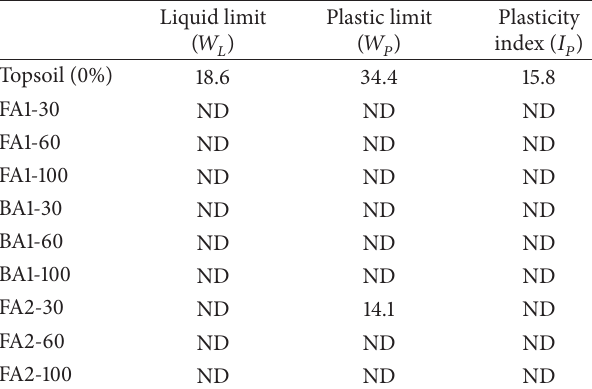
Figure 6: Soil composition of the simulated topsoil mixed with the coal ash at the mixing ratio of 0%, 30%, 60%, and 100%.